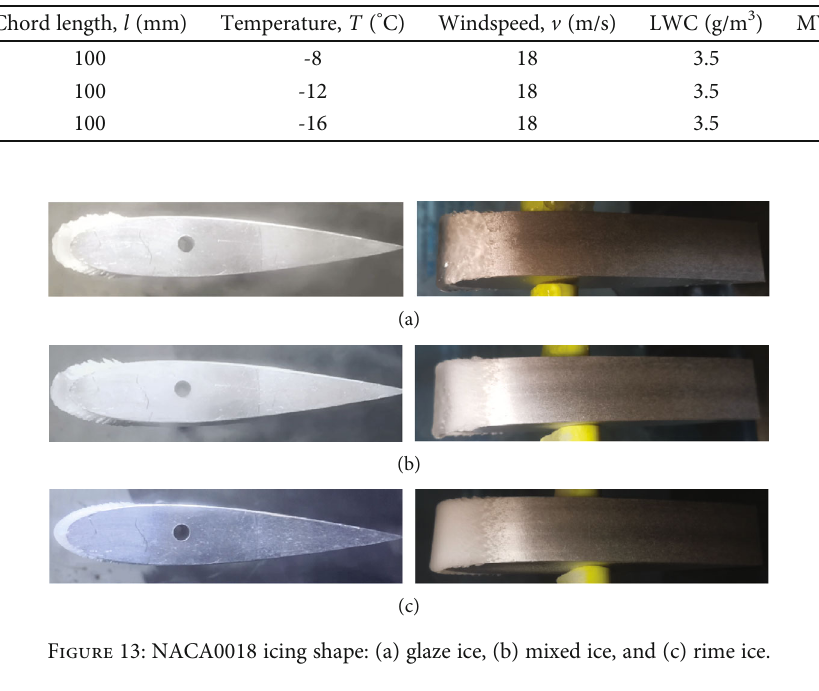
Table 2: Symmetric airfoil icing